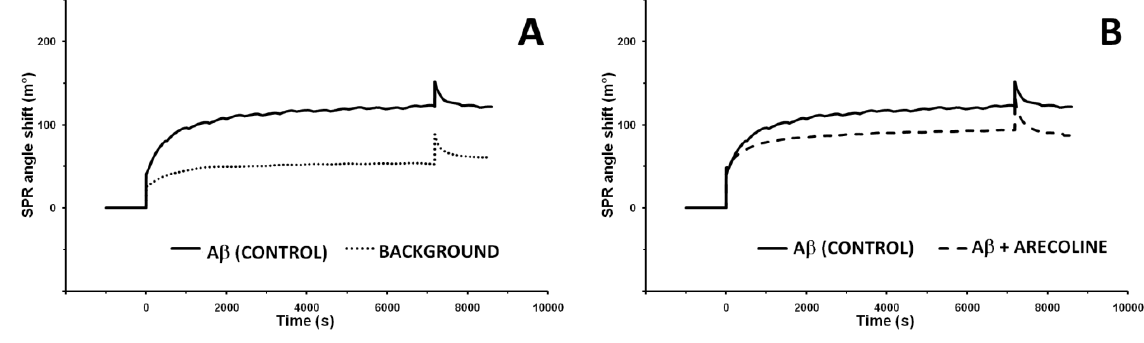
aggregations. ( A ) Aggregations 40 40 injected alone (control) or in the 40 -functionalized gold discs 40